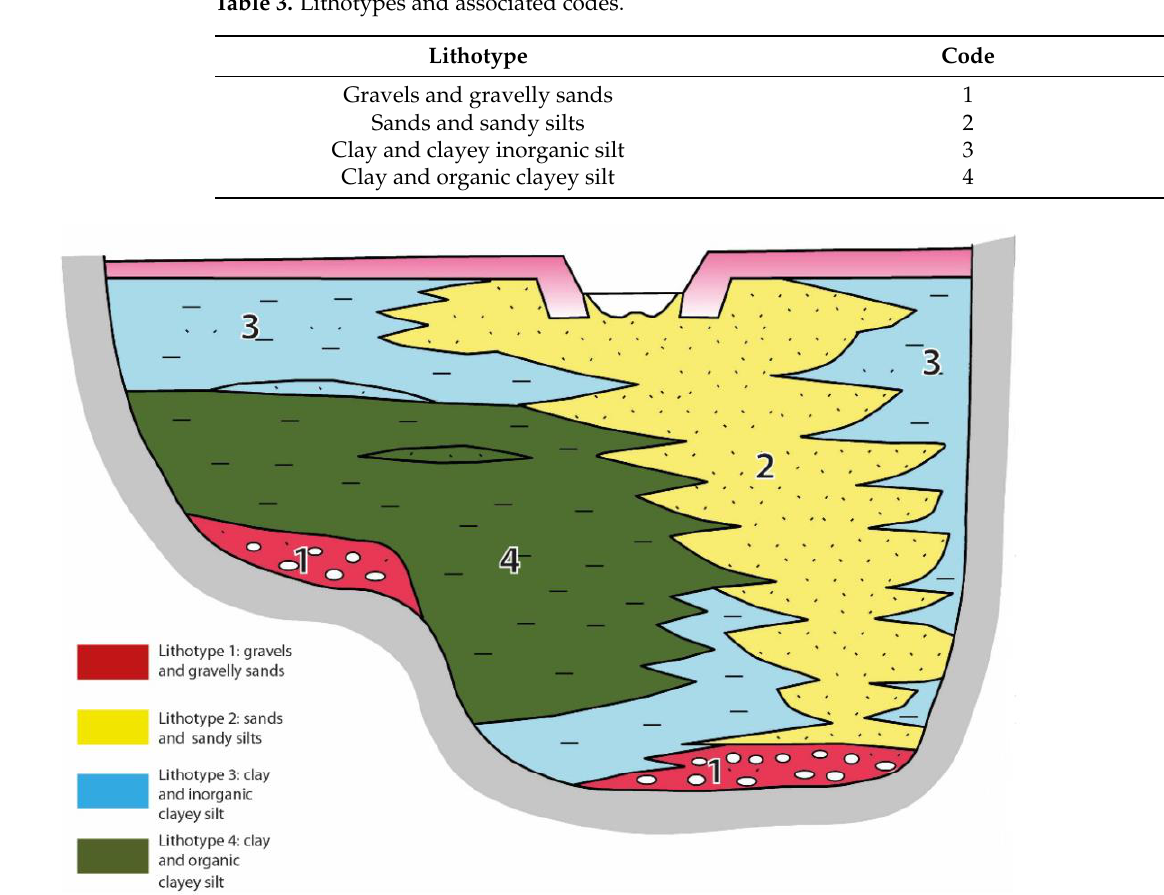
Figure 5. Descriptive section of the distribution of lithotypes in the alluvial